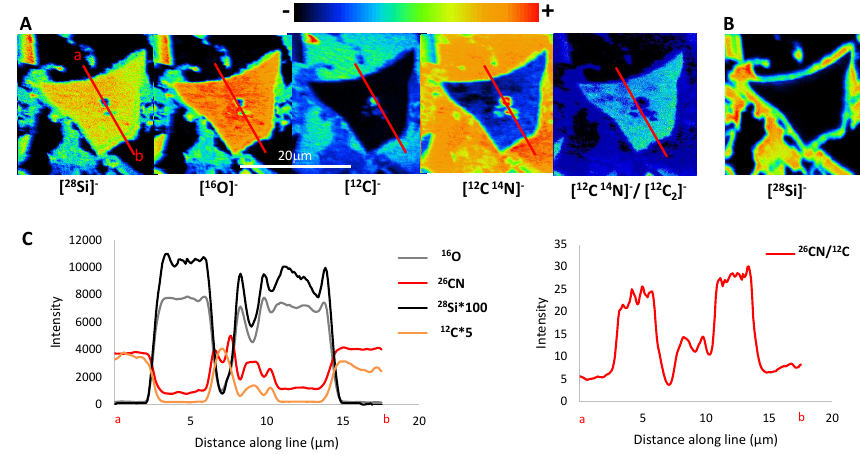
Figure 7. NanoSIMS images and intensities of a second typical GSC phytolith (rondel type) from TD-F-L (wheat) embedded in epoxy resin (polished section). Pre-sputtering: L1 = 2kV de-focused (60 × 60mm) [Cs] + primary beam, for 3min (a) [ 28 Si] − , [ 16 O] − , [ 12 C 2 ] − , [ 12 C 14 N] − and [ 12 C 14 N] − / [ 12 C 2 ] − images obtained with a [Cs] + primary beam with L1 = 2kV, D1-1 primary diaphragm (750µm), for 11min; (b) [ 28 Si] − image obtained with a [Cs] + primary beam increased with L1 = 4kV, D1-1 primary diaphragm, for 11min; (c) secondary ion intensities along line scans (red line in Fig.